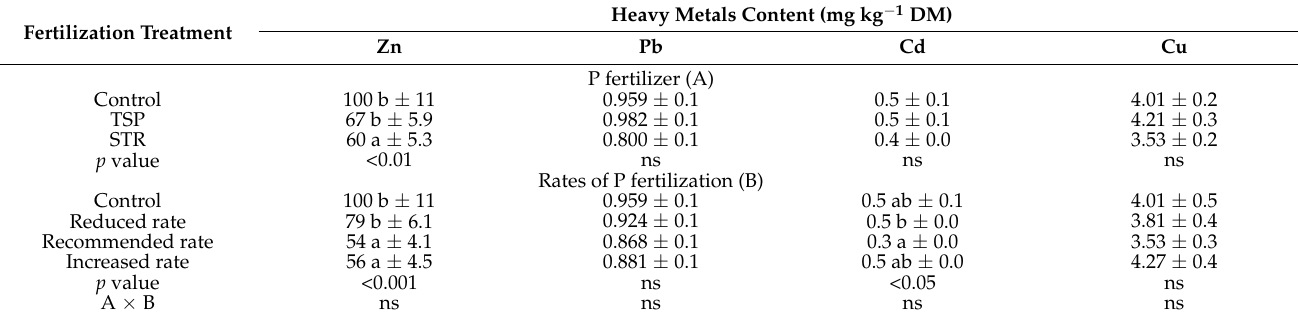
Table 5. Effect of P fertilization on selected heavy metal contents in butterhead lettuce. Fertilization Treatment